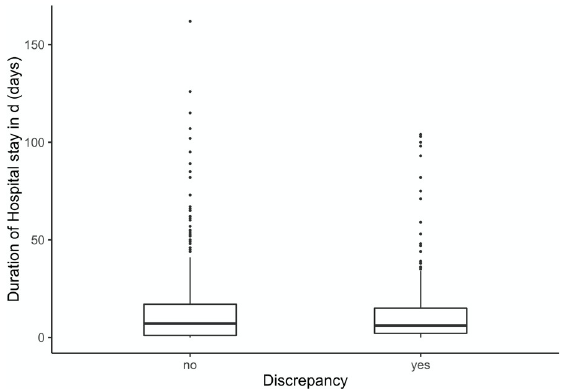
Fig 2. The Box-plot above represents the hospital duration compared to discrepancy